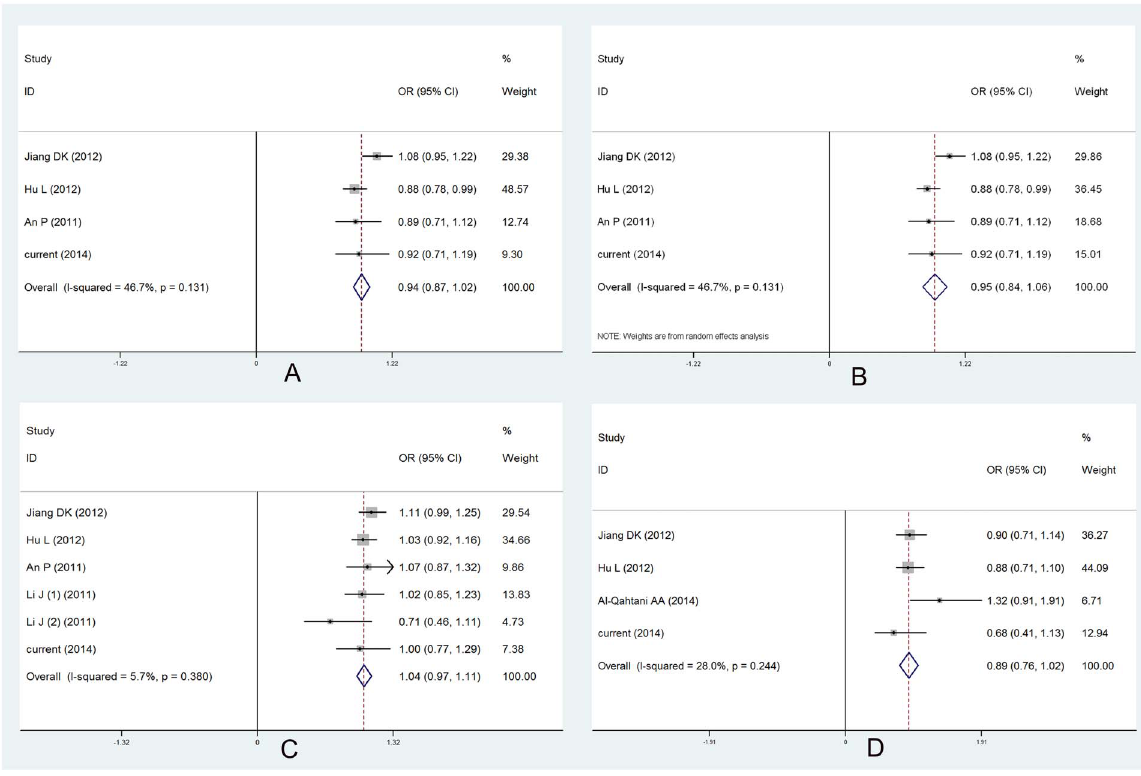
Figure 2. Forest plot for association of rs3077, rs9277535 and rs7453920 with HCC development. (A) Meta-analysis for rs3077 calculated in Fixed-effects model; (B) Meta-analysis for rs3077 calculated in Random-effects model; (C) Forest plot for rs9277535 with HCC development, Li J (1) represents southern Han Chinese, while (2) represents northern Han Chinese; (D) Forest plot for rs7453920 with HCC development.